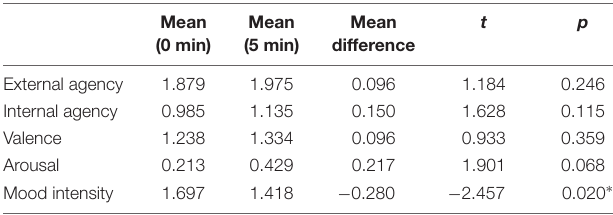
TABLE 1 | Overall changes in agency and affective variables during music listening.